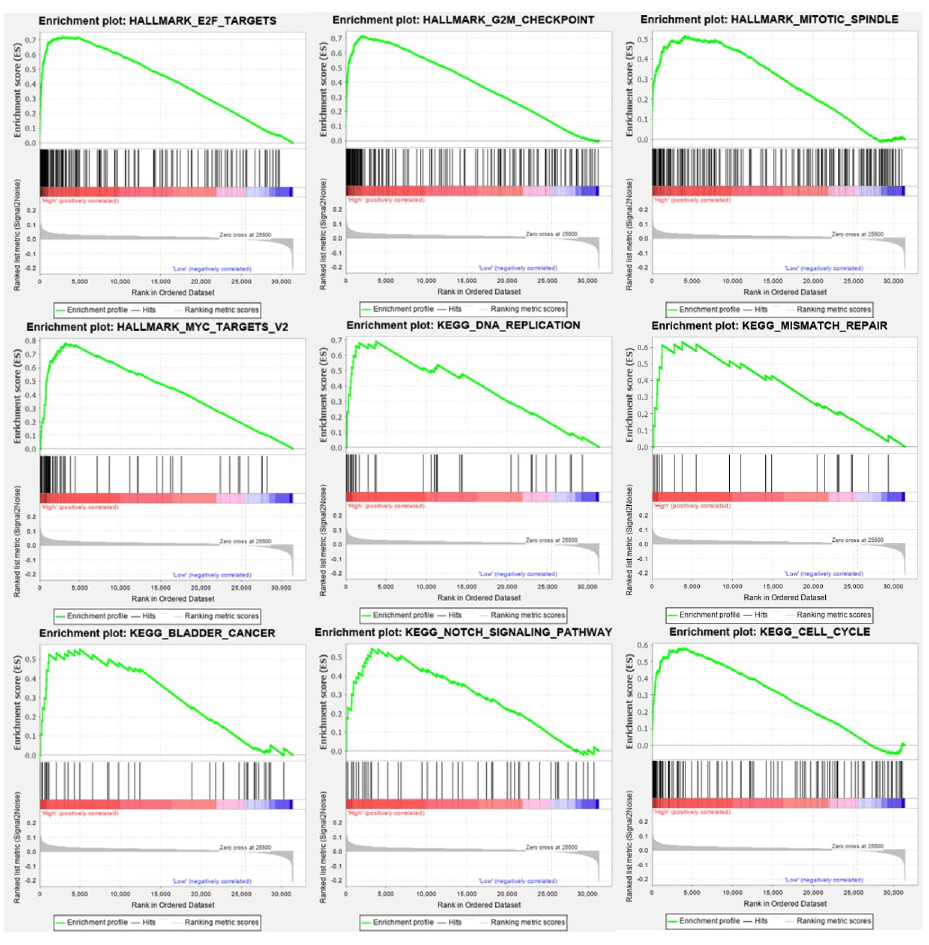
Fig 8. Genes enrichment analysis. The results above all meet the standards (FDR < 0.25, P-value < 0.05). The results showed that high expression of UBE2C were enriched in G2M check point, cell cycle, DNA replication, E2F targets, MYC targets, Notch signaling